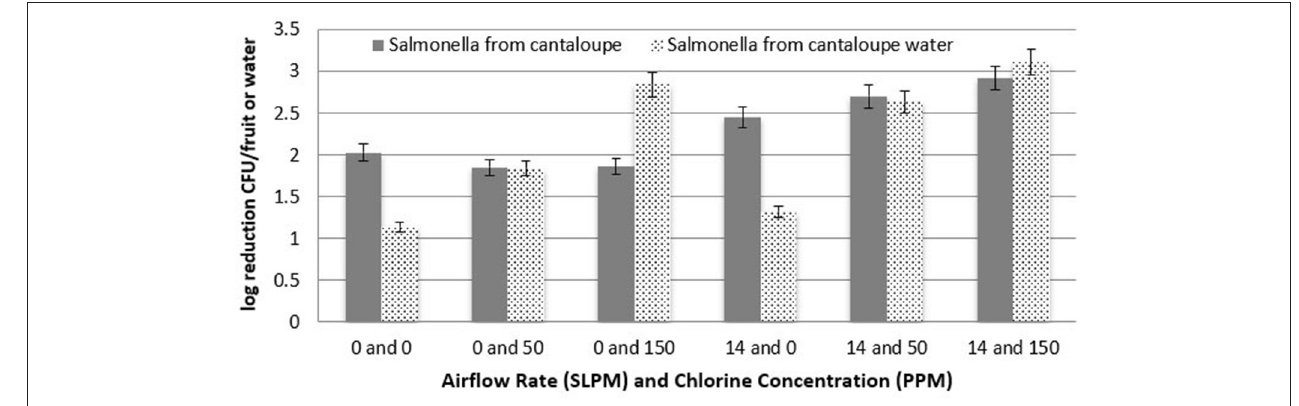
FIGURE 8 | Log reduction of Salmonella on cantaloupes as a function of airflow rate and chlorine concentration ( n = 6).